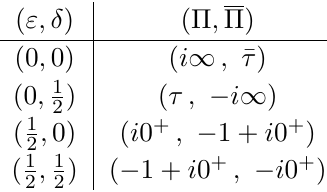
Table 2 . Limiting values of the moduli (Π , Π) in the spatial torus Regge limit for the four terms in the torus two-point function of twist